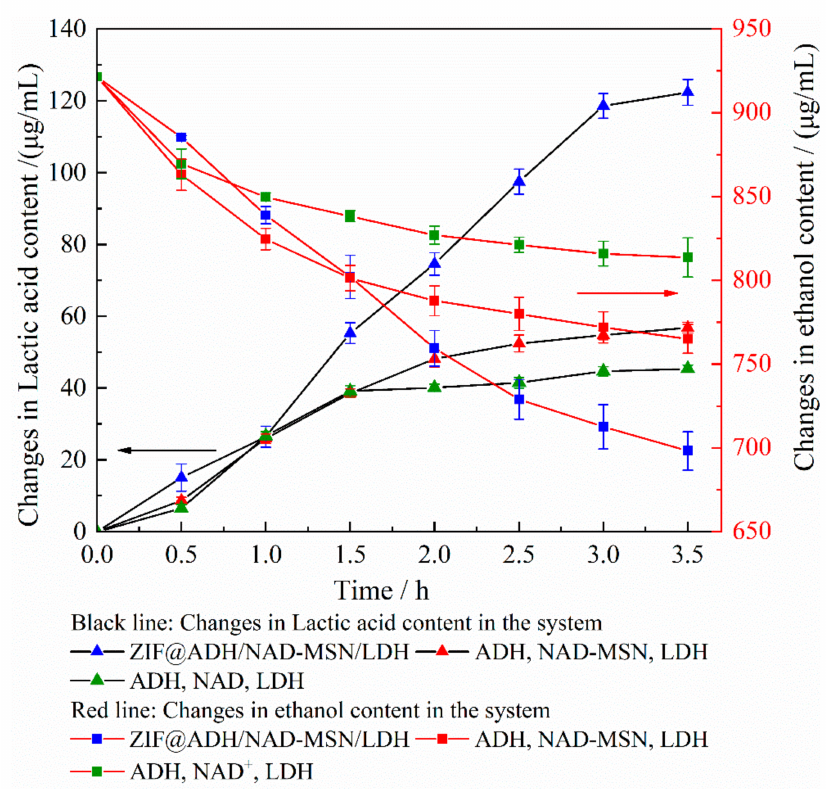
Figure 5. Changes in the content of lactic acid and ethanol in the system over time. ADH: Al- cohol dehydrogenase; LDH: Lactate dehydrogenase; NAD + : Nicotinamide adenine dinucleotide; ZIF@ADH/NAD-MSN/LDH: Core–shell nanocomposites prepared by ZIF-8 immobilized ADH, LDH and MSN-NAD; MSN-NAD: Mesoporous silica nanoparticles immobilized nicotinamide ade- nine dinucleotide. The black line with blue triangles represented the amount of lactic acid synthesized in the ZIF@ADH/NAD-MSN/LDH experimental group. The black line with a red triangle rep- resented the amount of lactic acid synthesized in the ADH, NAD-MSN, and LDH experimental groups. The black line with green triangles represented the amount of lactic acid synthesized in the ADH, NAD + , and LDH experimental groups. The red line with blue squares represented the amount of ethanol remaining in the ZIF@ADH/NAD-MSN/LDH experimental group. The red line with red squares represented the amount of ethanol remaining in the ADH, NAD-MSN, and LDH experimental groups. The red line with green squares represented the amount of ethanol remaining in the ADH, NAD + , and LDH experimental groups. Each experimental group was repeated three